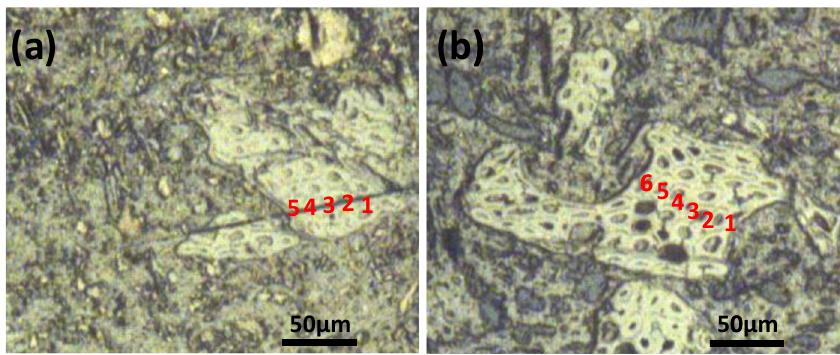
Figure 7: Microscope images of nanoindentation test regions of untreated ( a ) and MAPE and Si69 treated ( b ) RubWPC.